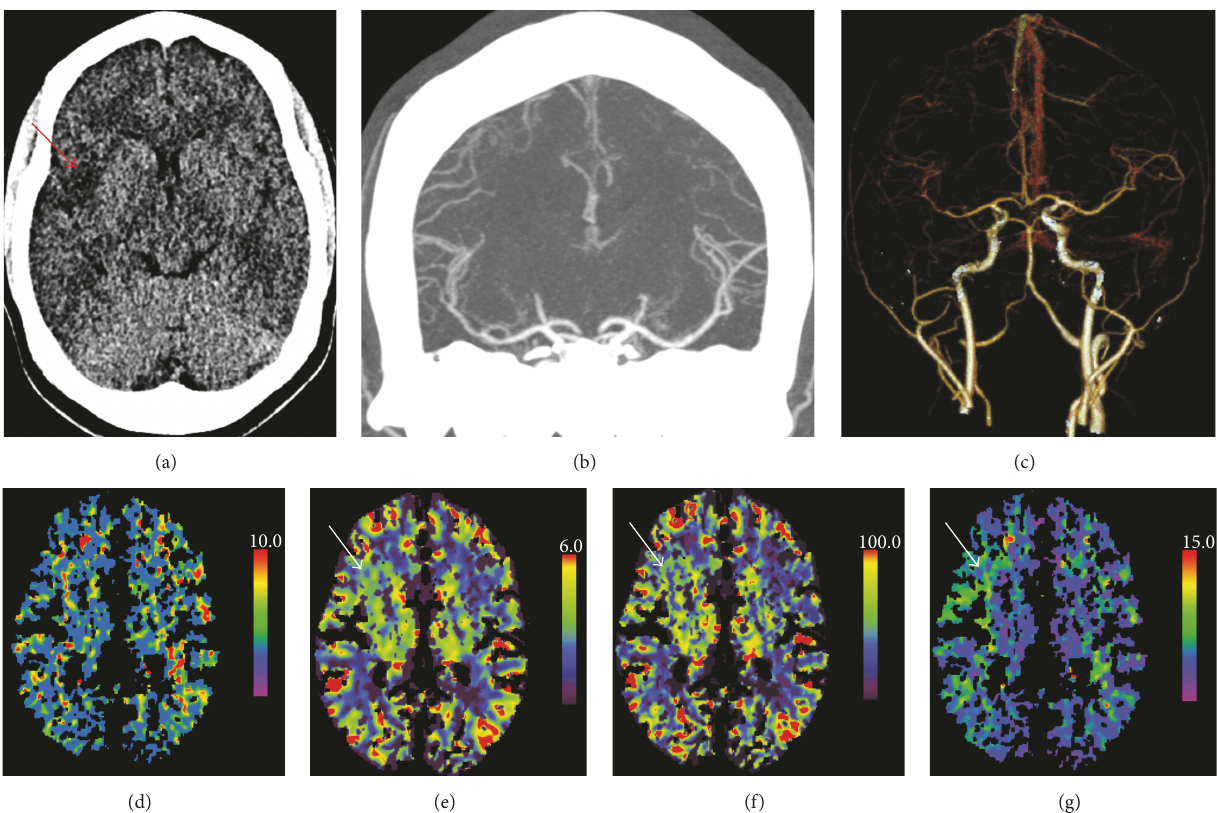
Figure 1: Axial unenhanced head CT scan (a) on the stroke windows (40/40 HU) demonstrated a low attenuation area in the right insular cortex (arrow). On CT angiography with coronal Minimal Intensity Projection (b) and reconstructed 3D (c) images, complete circle of Willis was identified with no gross findings of occlusion. The mean transit time (MTT) (d) showed no significant asymmetry. The cerebral blood volume(CBV)map(e)andthecerebralbloodflow(CBF)map(f)demonstratedaslightasymmetrywithincreasedCBVandCBF,respectively, in the posterior right frontal region just above the subinsular cortex extending along the anterior aspect of the subinsular cortex (arrow). The time to drain (TTD) map (g) revealed asymmetrically delayed blood drainage from the left posterior frontal region including the entire subinsular cortex (arrow). Luxury perfusion following cerebral infarction is the most likely diagnosis in the presence of changes on the unenhanced portion of the CT examination.